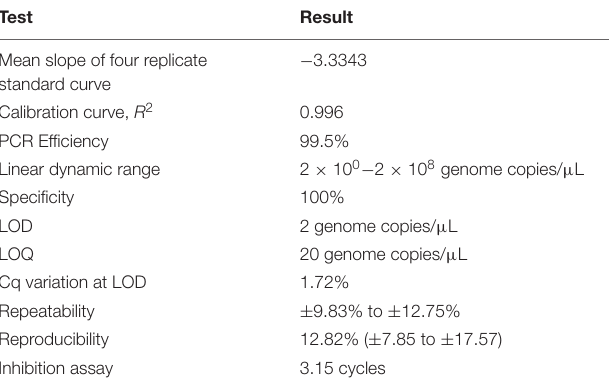
TABLE 3 | Performance parameters of the PEDV qPCR